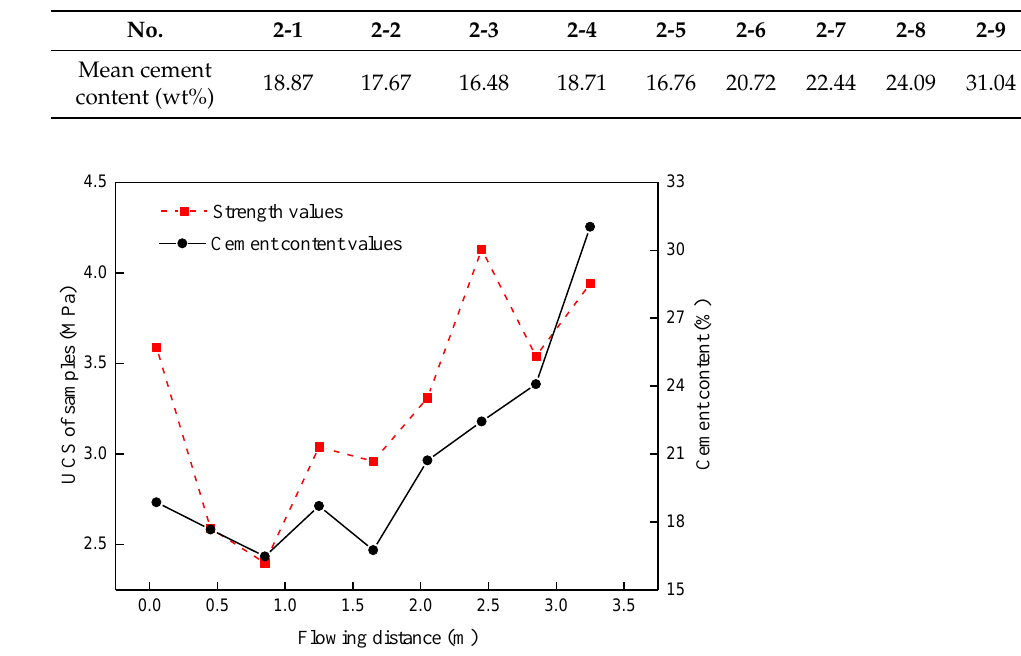
Figure 8. Comparison chart of the cement contents and UCS of samples in row 2 along the flowing direction.